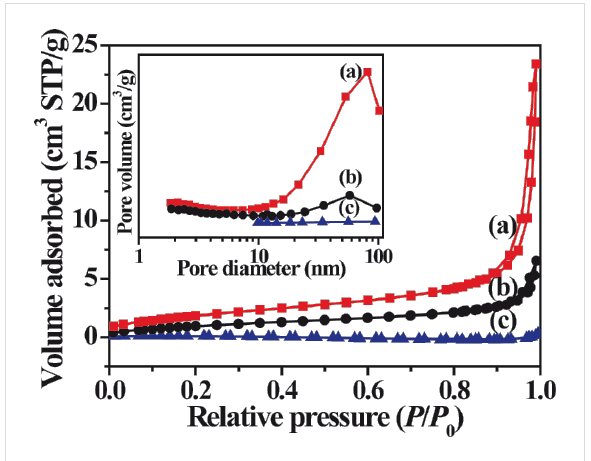
Figure 3: TEM (a) and HRTEM (b) images of Ag 2 CrO 4 sample prepared by microemulsion method. The inset of (b) is the corres- ponding FFT image.